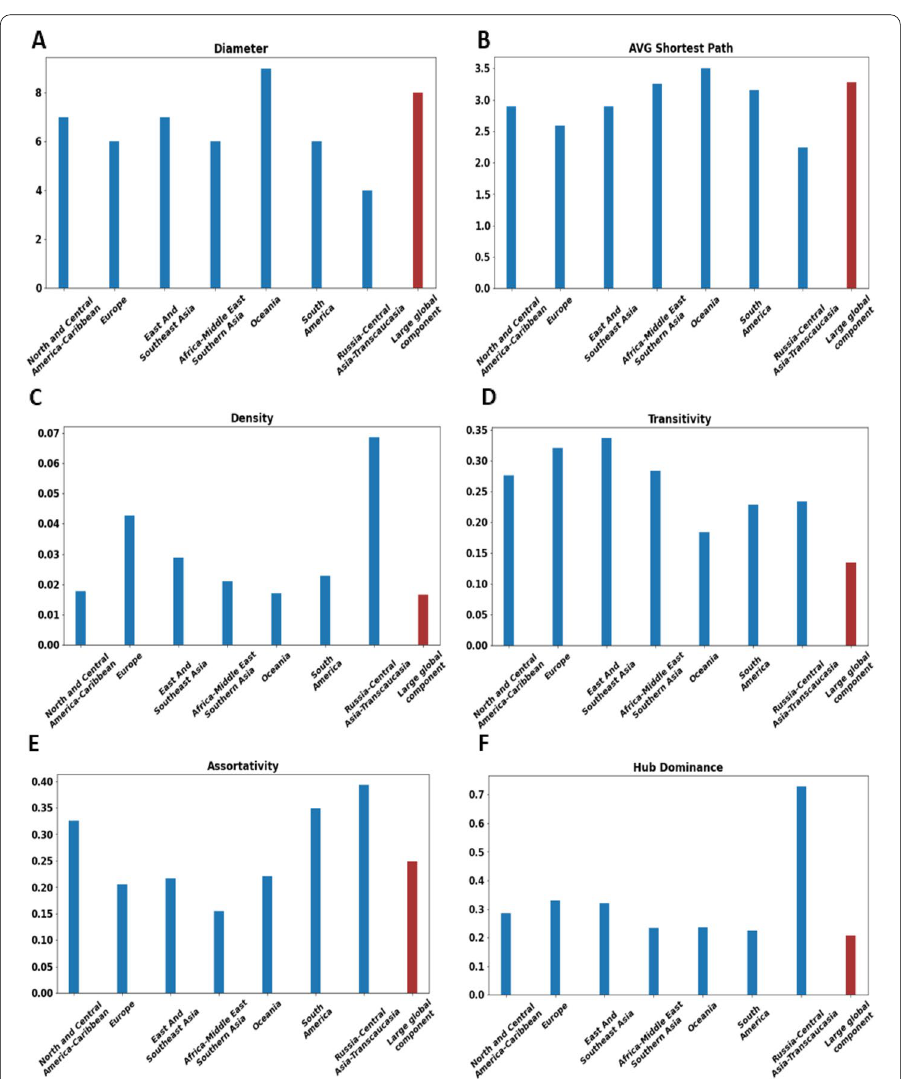
Fig. 6 Basic topological properties of the large components. Each bar plot concerns a different property (Diameter, Average shortest path, Density, Transitivity, Assortativity, and Hub dominance). The blue bar corresponds to the large local component. The red bar corresponds to the large global component. For assortativity, absolute values are plotted, but in reality, the values are